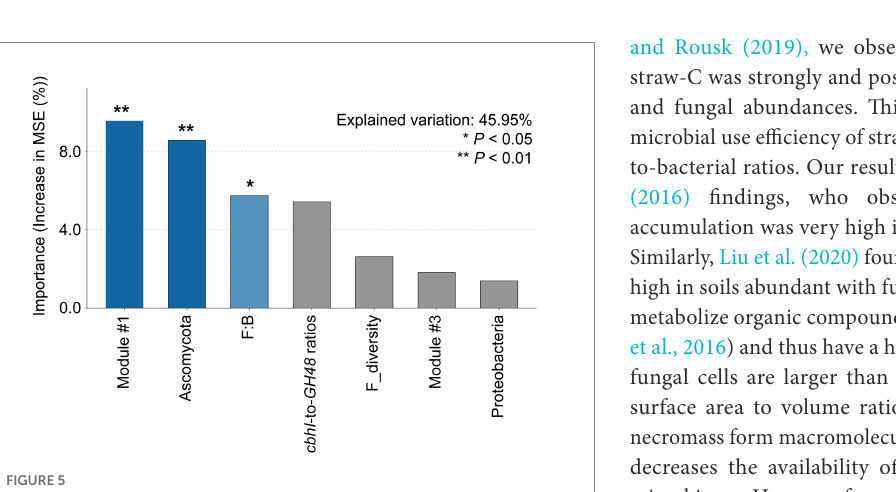
FIGURE 5 Mean predictor importance of the relative abundances of indicators of microbial community properties on the microbial use efficiency of straw-C. The contribution (% of increased mean square error) is calculated based on random forest analyses. Percentage increases in the MSE (mean squared error) of variables estimate the importance of these predictors. The MSE% values were directly proportional to the importance of a given predictor. * p < 0.05, ** p <